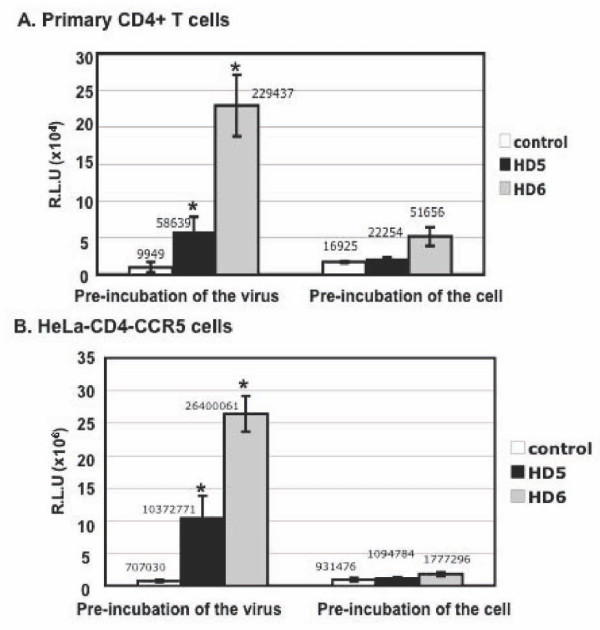
HD5 and HD6 enhanced HIV infectivity by targeting the virus. Pseudotyped HIV-1JR-FL luciferase reporter virus was incubated with or without HD5 or HD6 (20 μg/ml) at 37°C for 1 hour followed by infection of primary CD4+ T cells (A) or HeLa-CD4-CCR5 cells (B) as described in Materials and Methods. To determine the effect of defensins on the target cell, primary CD4+ T cells or HeLa-CD4-CCR5 cells were incubated with defensins in the presence of FBS for 1 hour, washed, and exposed to pseudotyped HIV-1JR-FL reporter virus for 2 hours. Cells were washed and cultured for 48 hours before measuring luciferase activity. Difference between defensin-treated virions and non-treated control was significant (*p < 0.05) as calculated by two-tailed, paired Student t test. The value of mean luciferase readout is shown. Data are means ± SD of triplicate samples and represent three independent experiments.